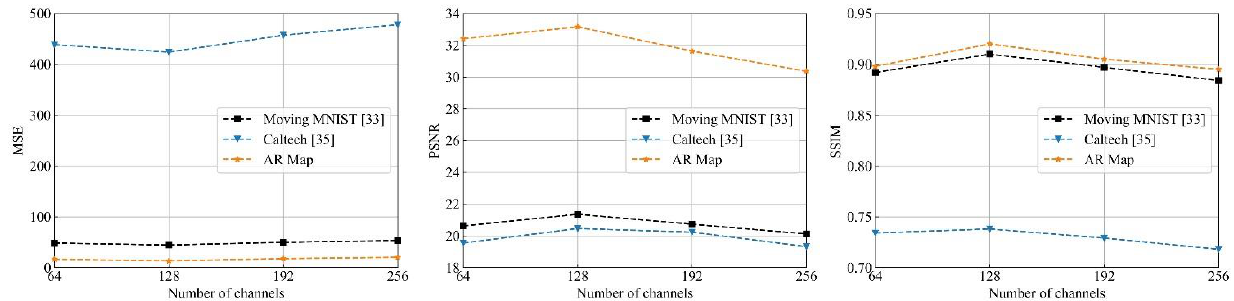
Figure 9. Prediction performance under different number of channels in bottom layer.